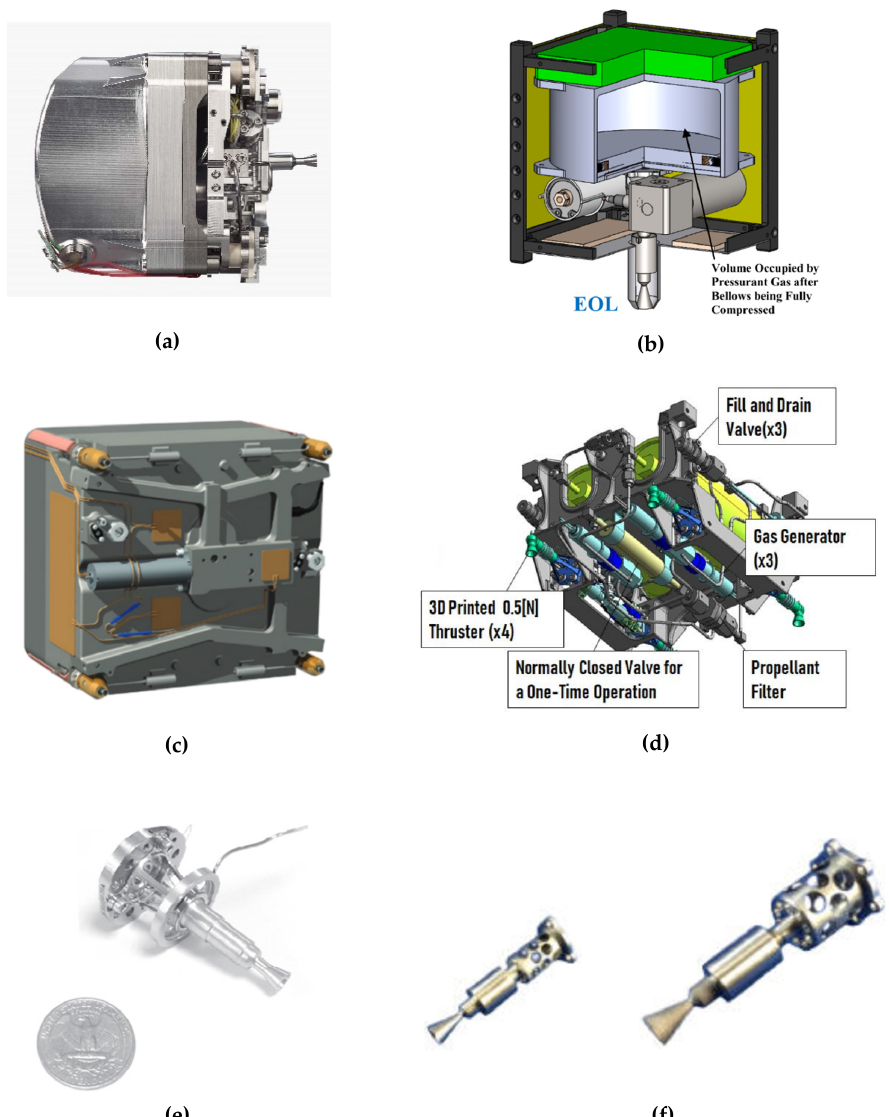
Figure 8. State of the art in green monopropellant propulsion: ( a ) EPSS C1 CubeSat Propulsion System. (Image courtesy of NanoAvionics [53]); ( b ) Busek 1U CubeSat Green Propulsion Module. (Image Courtesy of Tsay et al. [45]—Busek Co., Inc.); ( c ) MPS-135 Modular Propulsion System. (Image Courtesy of Aerojet Rocketdyne [54]); ( d ) Pinot-G propulsion module. (Image courtesy of IHI Aerospace Co. [55]); ( e ) HPGP 100 mN thruster. (Image Courtesy of Bradford-ECAPS); ( f ) BGT-X1 and BGT-X5 green monopropellant thrusters. (Image Courtesy of Busek Co.).